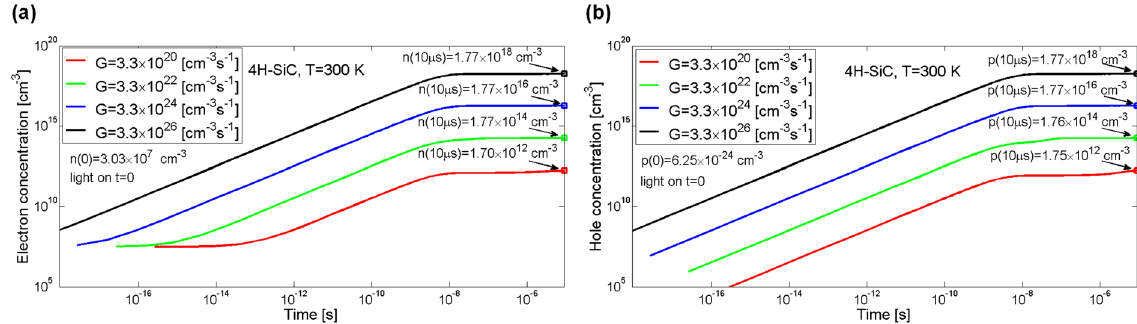
Figure 3. Simulation of temporal changes in electron concentration in the conduction band ( a ) and hole concentration in the valence band ( b ) in 4H-SiC material. Parameter G is the generation rate